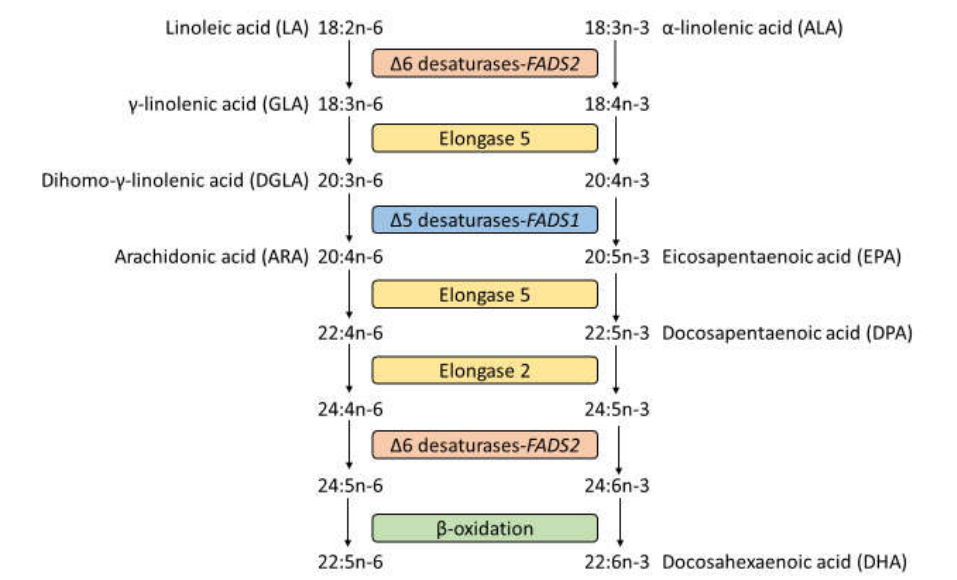
administered 13 C-linoleic acid (LA) (18:2n−6) to healthy young and elderly subjects and